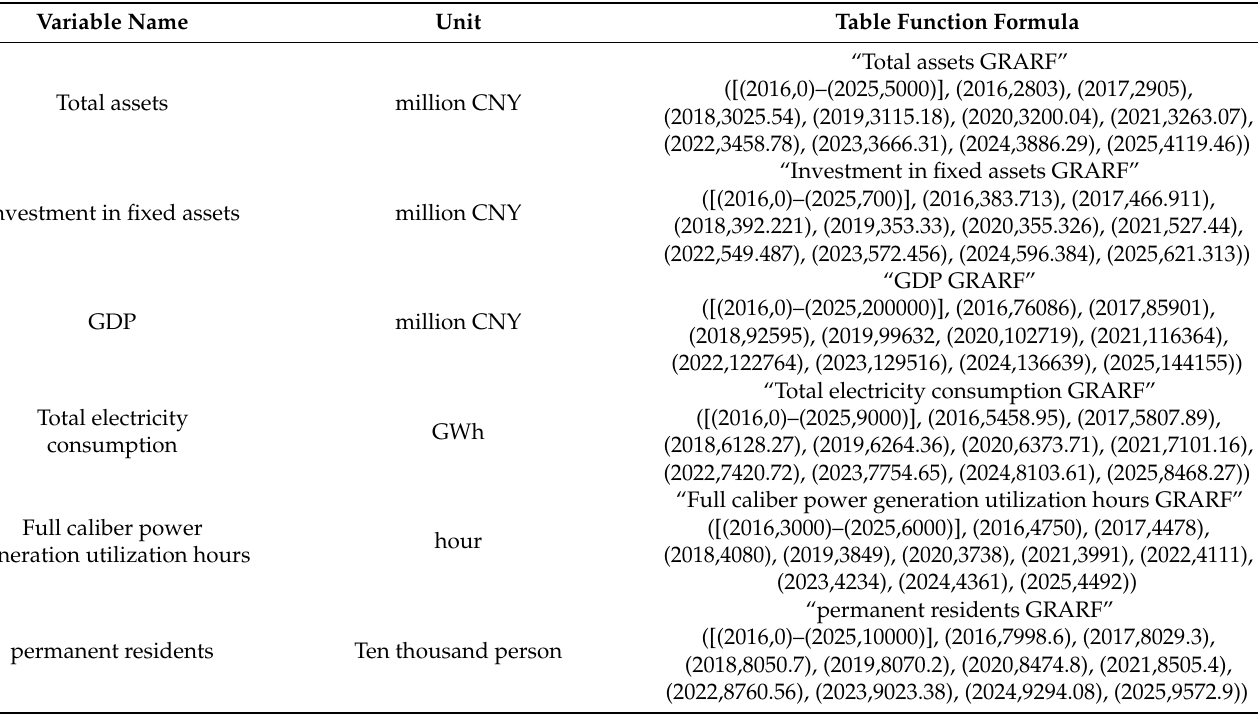
Table 2. Auxiliary variable table function formula